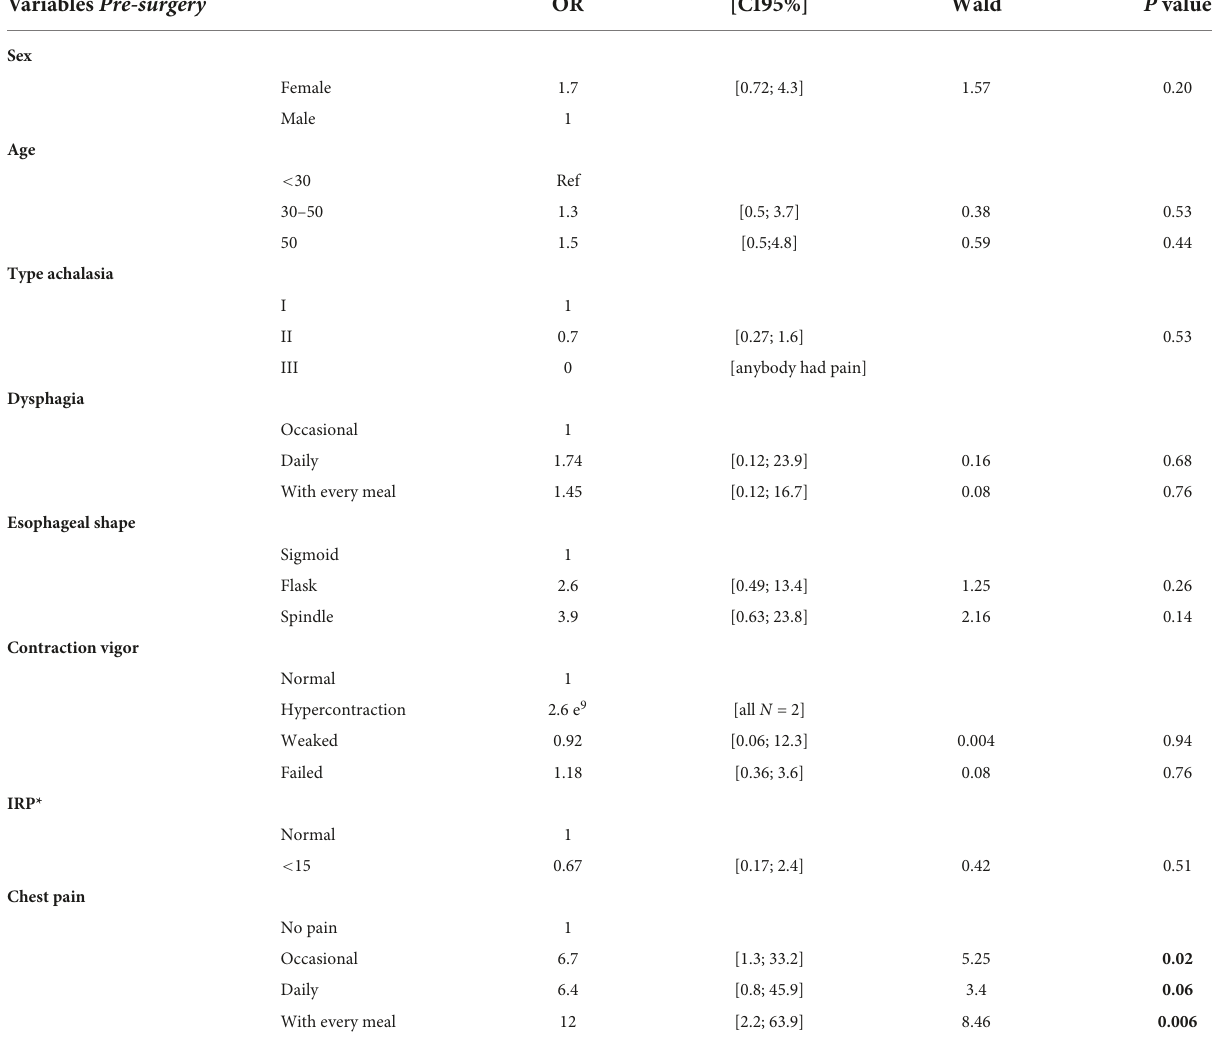
TABLE 2 Non-adjusted logistic regression analysis of occasional chest pain vs. no pain at 12 months after surgery ( n = 66). Variables Pre-surgery